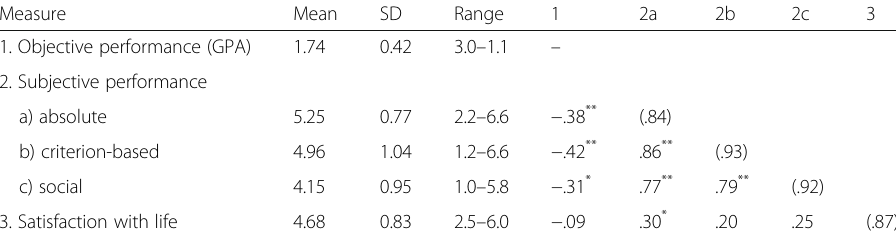
Table 1 Means, Standard Deviations, Ranges, and Intercorrelations of Used Measures ( N = 61) Measure Mean SD Range 1 2a 2b 2c